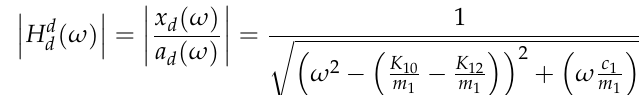
  d d H  in Figure 1). Accompanying